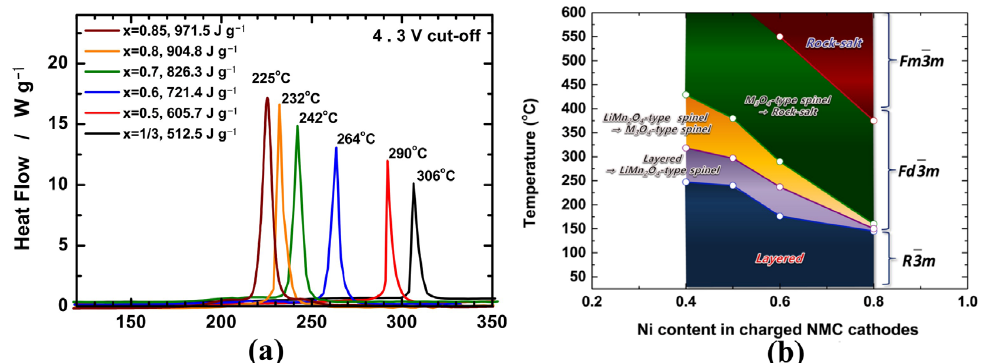
Figure 1. ( a ) DSC results of the Li 1- δ [Ni x Co y Mn z ]O 2 materials (x = 1/3, 0.5, 0.6, 0.7, 0.8 and 0.85) [27]; ( b ) Schematic illustration depicting the phase stability map of the charged NMC cathode materials during heating [28].